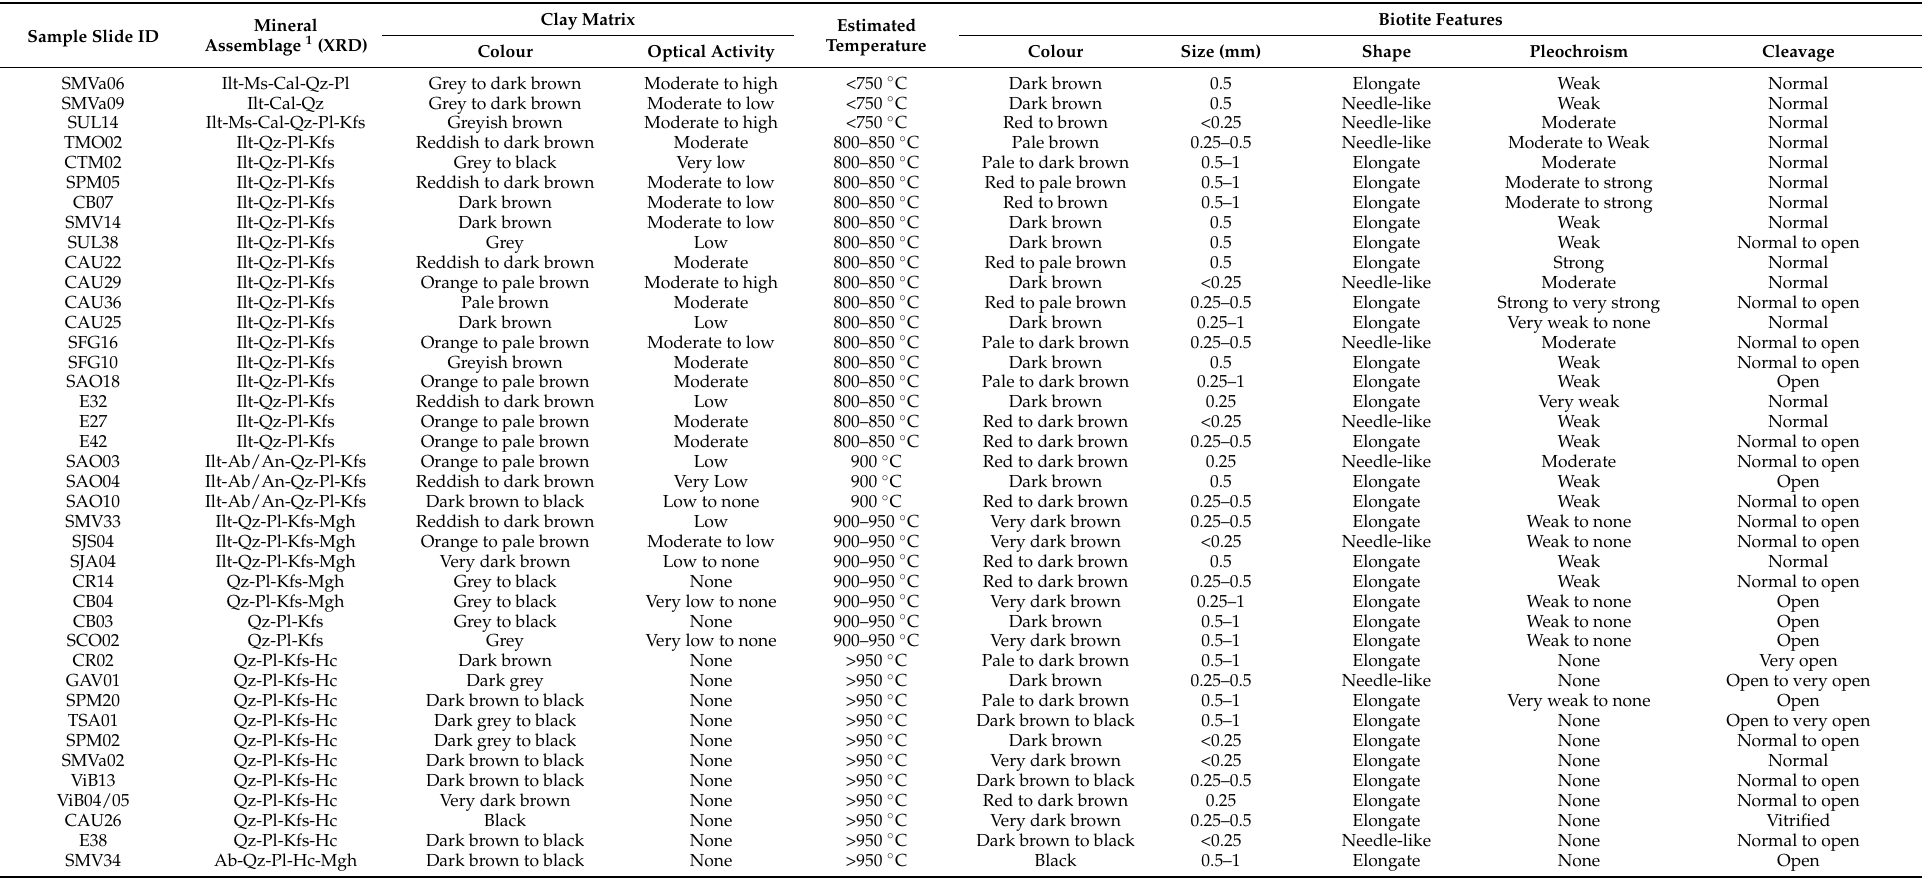
Table 1. Details of the 40 medieval greyware pottery samples analysed in this paper, including their mineralogical assemblages as determined by XRD, the colour and optical activity of their matrices observed in thin-sections under crossed polars, their estimated firing temperature and the optical properties of the biotite inclusions contained within